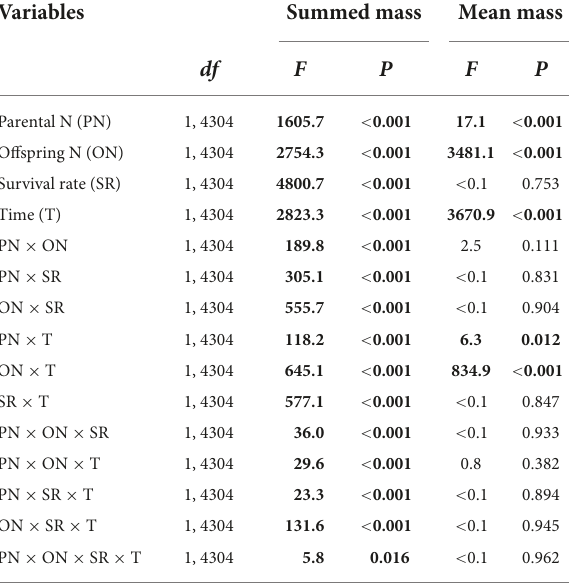
TABLE 3 Effects of parental N levels, offspring N levels, the survival rate of offspring, and developmental time of offspring on summed and mean performance of clonal offspring produced by one parental